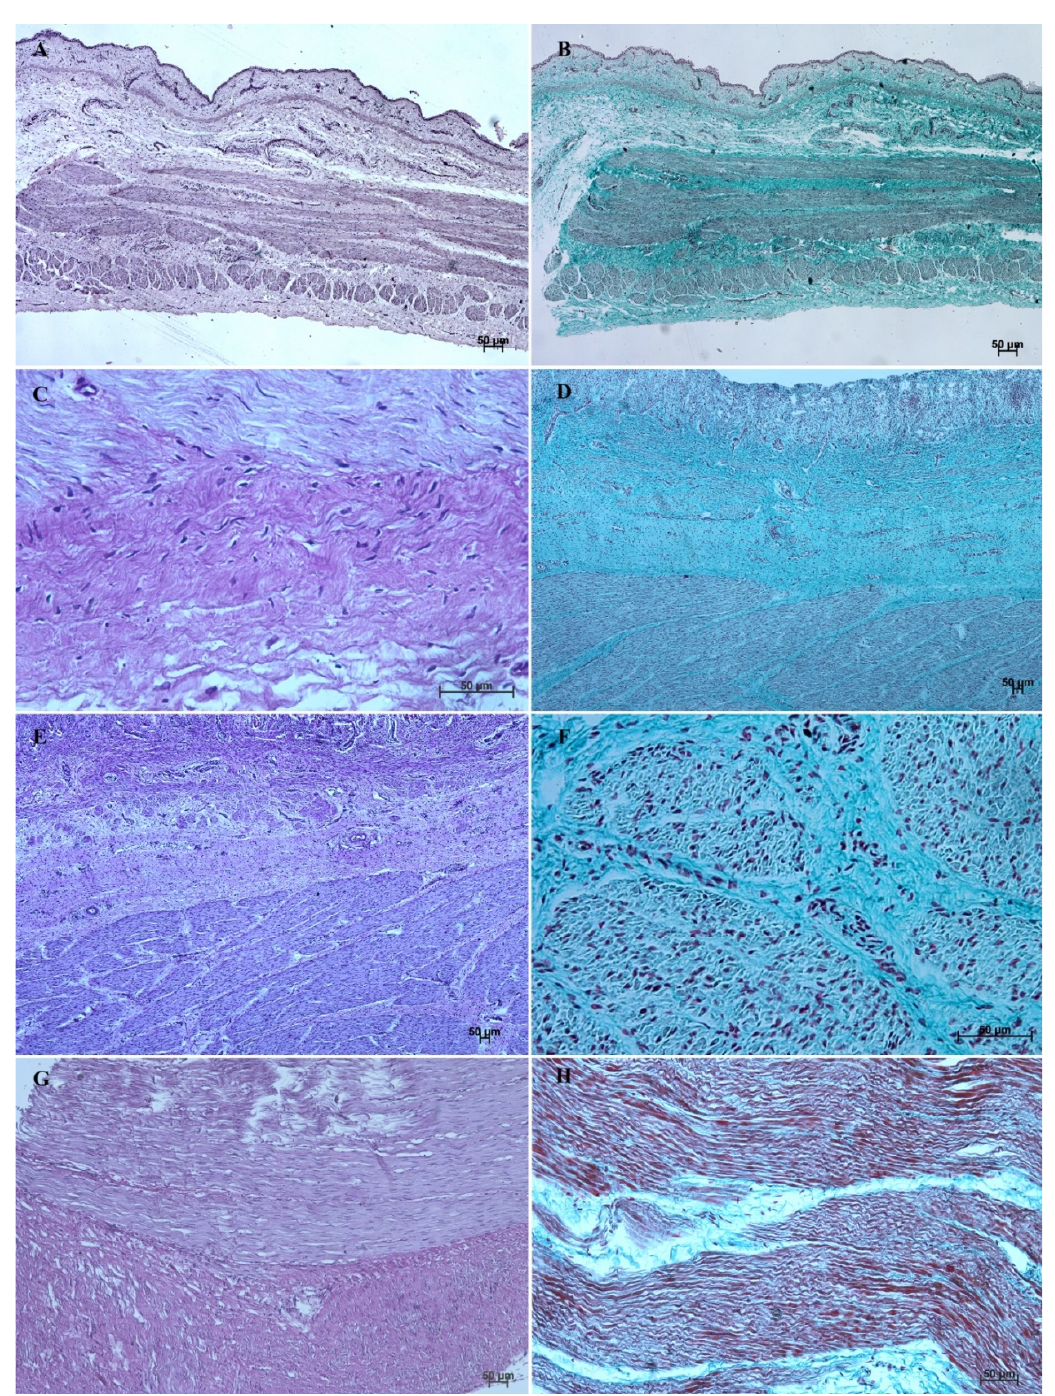
Figure 10. Histological structure of the muscular layer of stomach wall (hematoxylin-eosin staining and Masson-Goldner staining). ( A , B )—the first age group (20×); ( C , D )—the second age group (40× and 5×); ( E , F )—the third age group (5× and 40×); ( G , H )—the reference adult group (10× and 20×).